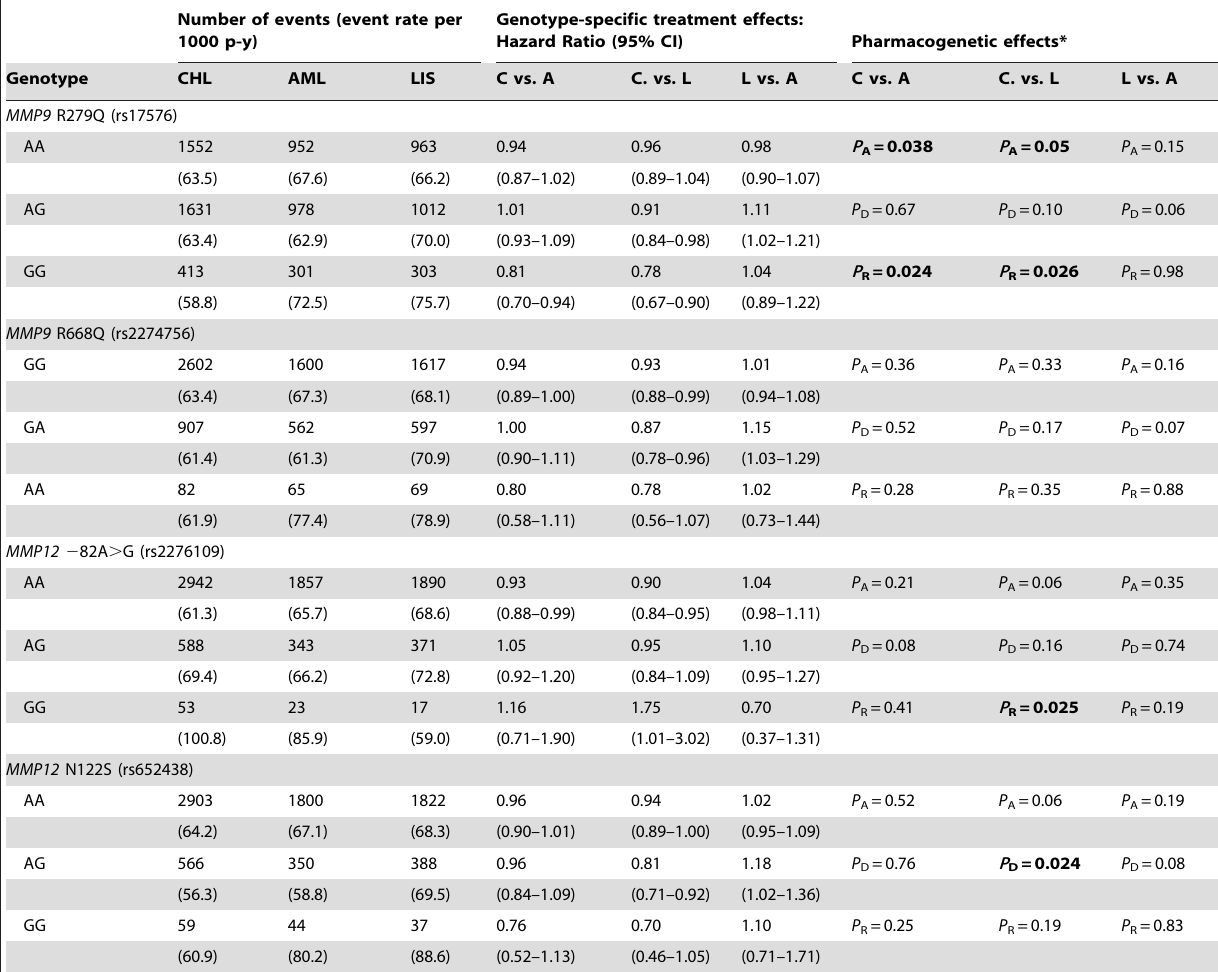
Table 5. Pharmacogenetic effects of MMP genetic variants on